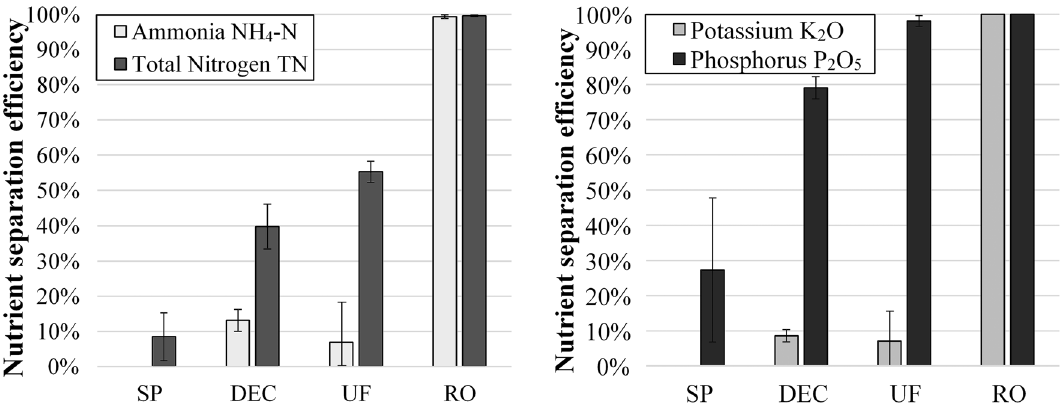
Fig. 8 Cumulated concentration-based separation efficiencies for total nitrogen (N (P 2 O 5 )